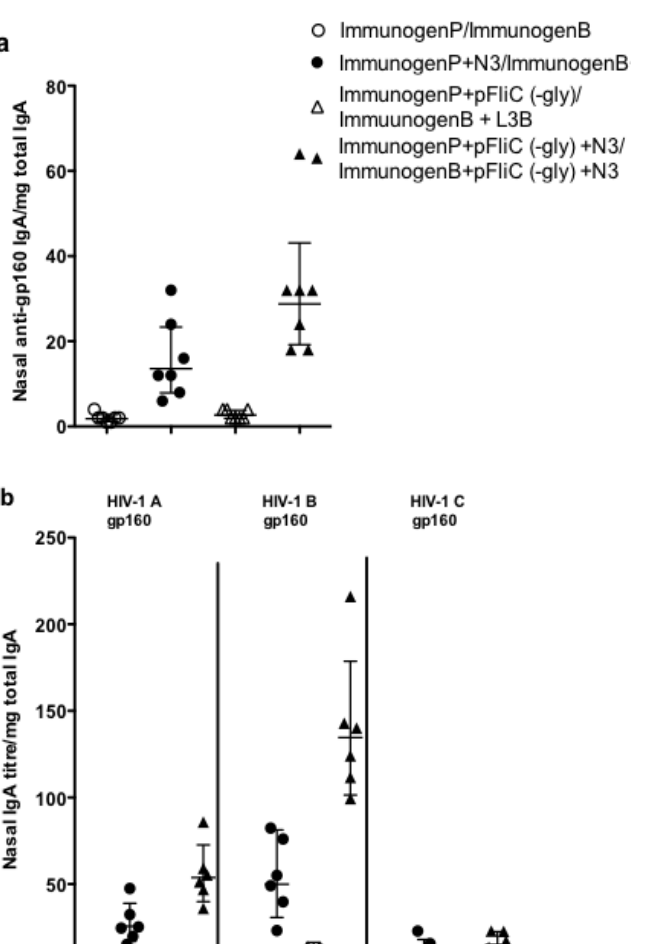
Figure 6. Mucosal antibody responses to gp160. ( a ) Nasal IgA anti-rgp160; ( b ) Nasal IgA anti-gp160 cross-reactivity against clade A, B, and C envelope antigens. Priming (ImmunogenP, plasmids) and boosting (ImmunogenB, rec proteins) groups are shown